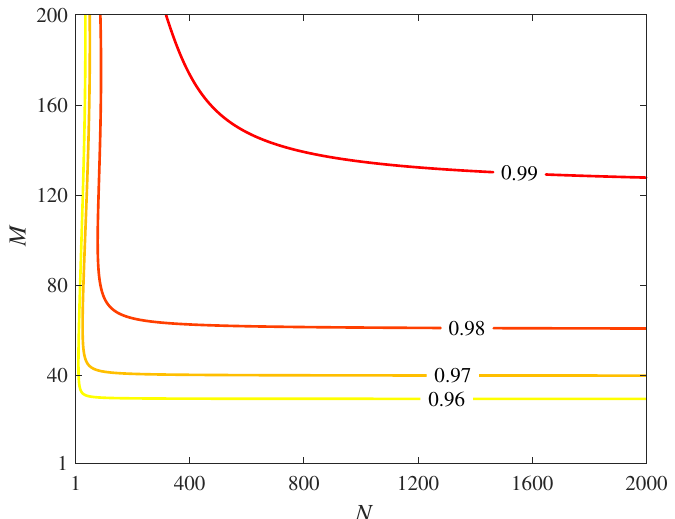
Figure 3. The success probability of counterfactual GHZ state distribution for a network of 50 partici- pants where the CQZ gate held by each participant has N = 2000 and M = 200 of inner and outer cycles,